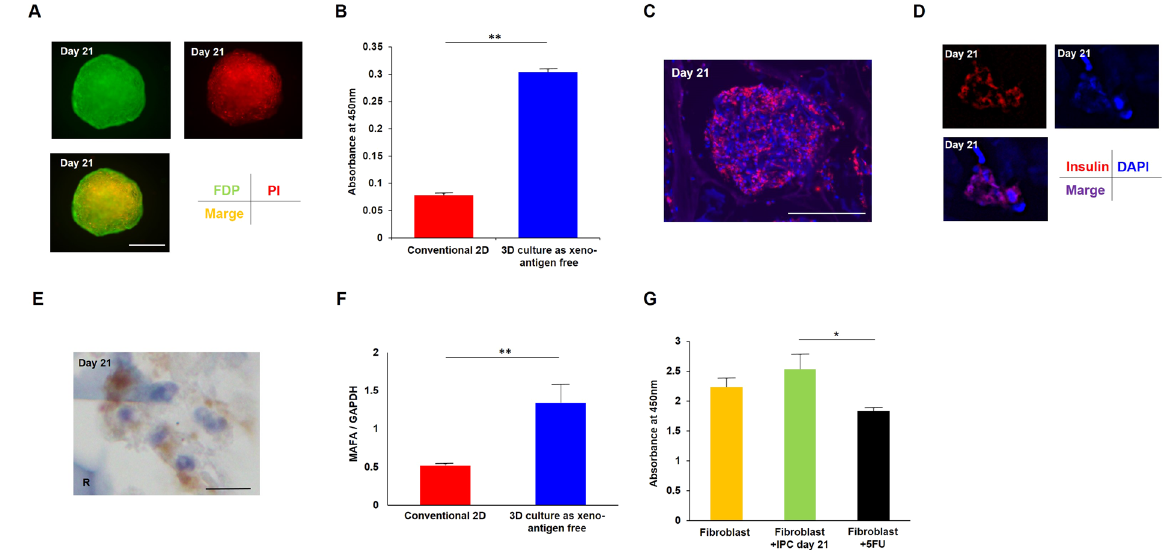
Figure 2. Cell quality of IPCs generated by the 3D cultured protocol was better than IPCs from conventional monolayer culture. (A) The cell viability of 3D cultured IPCs at day 21 was determined by FDP/PI staining. Green: FDP staining, red: PI staining, orange: merged image. Scale bar, 100 μ m. (B) Absorbance at 450 nm showed significantly better cell viability of 3D cultured IPCs compared with IPCs from conventional 2D culture method. ** P < 0.01, un-paired t-test. (C) Immunofluorescence of generated IPCs at day 21. Red: insulin, blue: DAPI. Scale bar, 100 μ m. (D) The larger image shows the insulin-positive area was the cytoplasm. Red: insulin, blue: DAPI. (E) Light microscopy analysis also showed the cytoplasm of generated IPCs was positive for insulin staining. Scale bar, 10 μ m. R: RCP petaloid μ -piece, stained blue. (F) MAFA mRNA expression was significantly higher in 3D cultured IPCs compared with IPCs from conventional 2D culture method by unpaired t-test. ** P < 0.01. Error bar indicates standard deviation. (G) Generated IPCs did not show significant adverse effects on human dermal fibroblasts in cell toxicity, although 100 μ M 5-FU addition showed significantly reduced viability. * P < 0.05, one-way